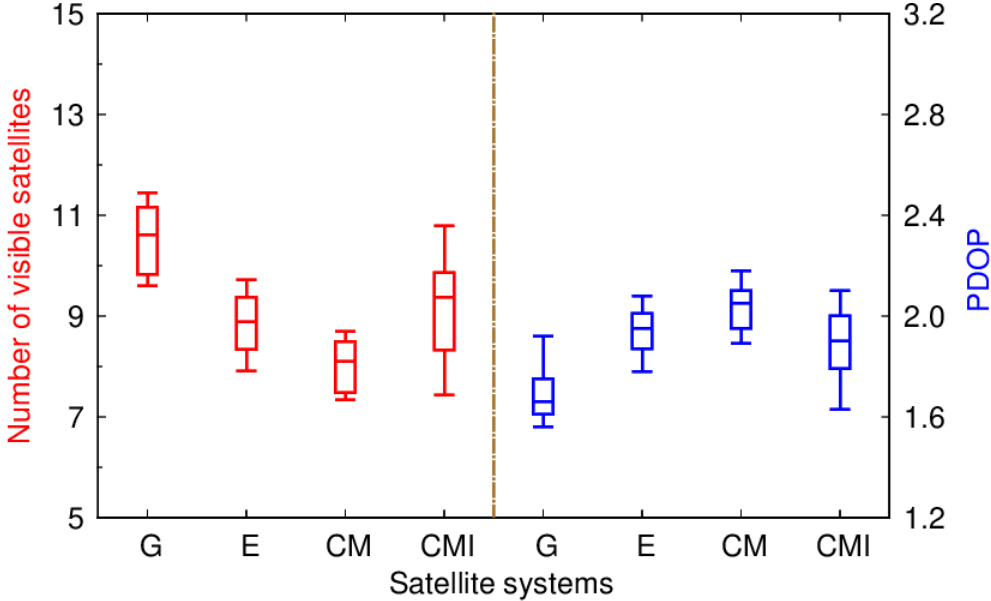
Figure 4. Distribution of the number of visible satellites and PDOP values for different systems (G is short for GPS, E is short for Galileo, CM is short for BDS-3 MEO, and CMI is short for BDS-3 MEO+IGSO) over a day (1 September 2022) with an elevation cut-off of 7°.